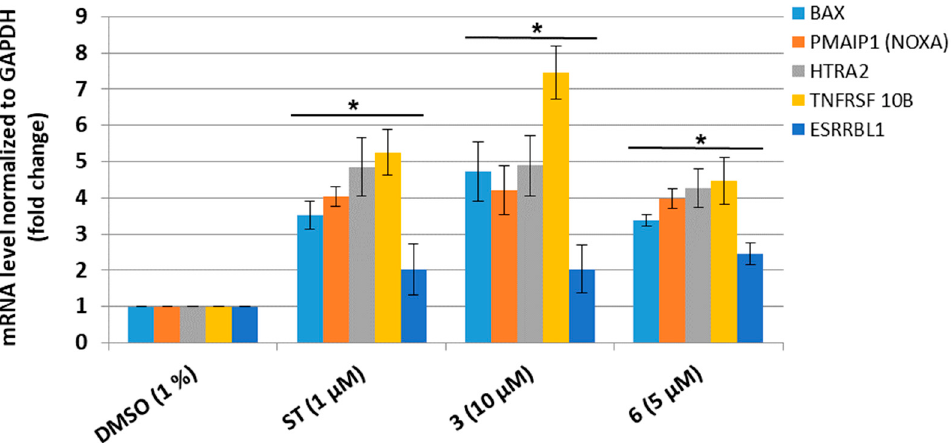
Figure 4. Real time reverse transcription quantitative polymerase chain reaction (RT-qPCR) analysis of relative mRNAs levels in K562 cells after 18 h of incubation with staurosporine (1 µ M, positive control) and tested compounds 3 (10 µ M) and 6 (5 µ M). Levels of analyzed mRNAs in K562 cells treated with 1% DMSO (reference sample) were expressed as 1.0. Statistically significant changes are indicated with asterisks ( p < 0.05, Mann-Whitney U